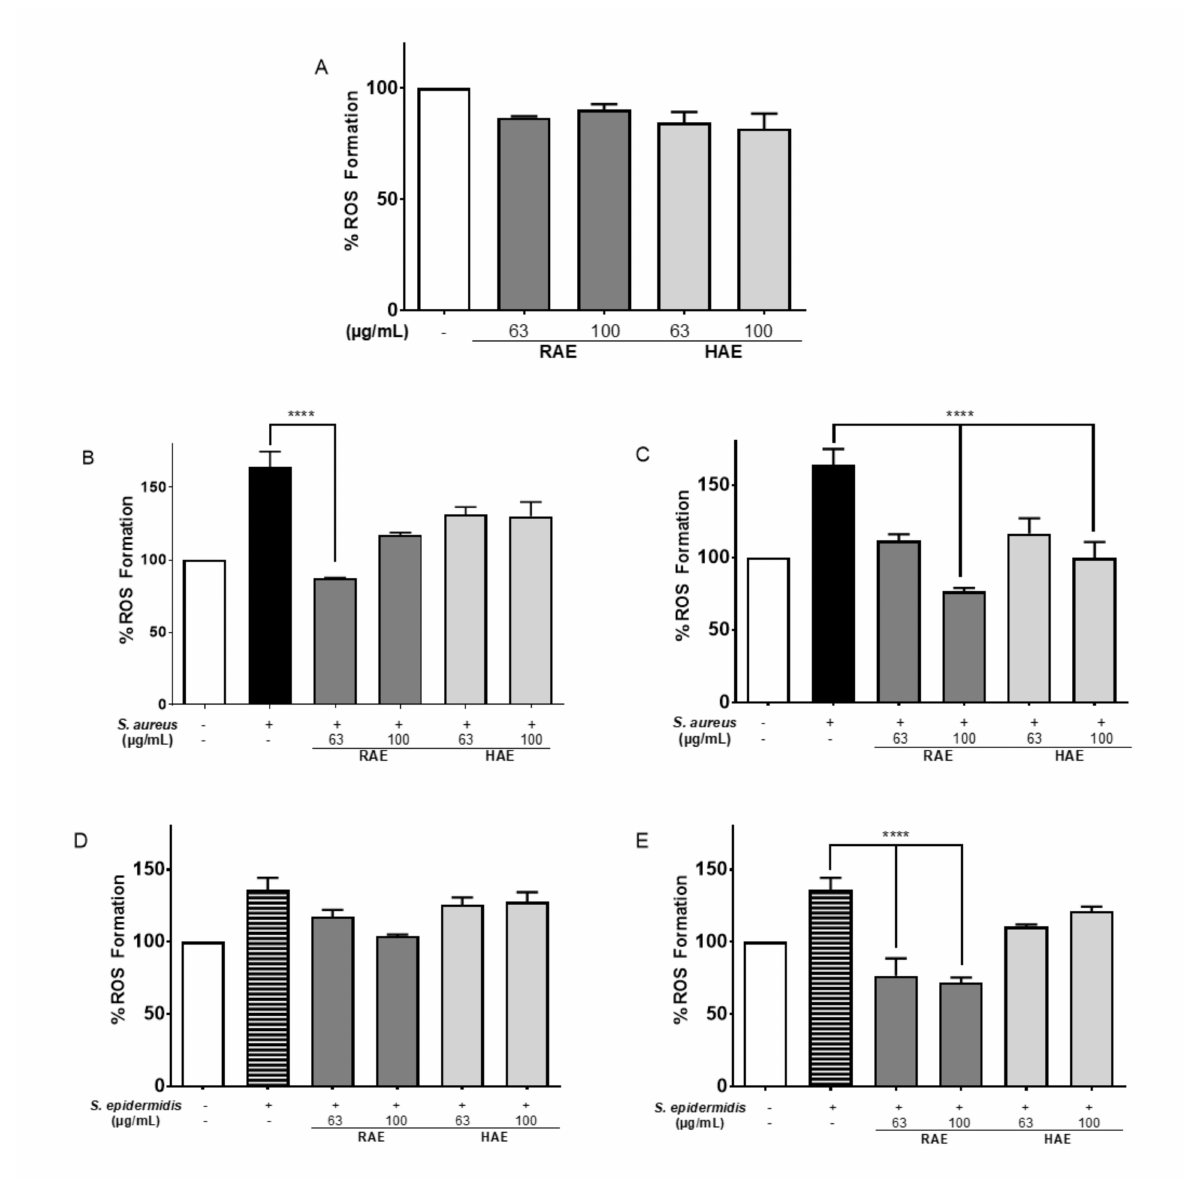
Figure 5. Percentage of reactive oxygen species. ( A ) HDFa cells exposed to MS extracts for 3 h. ( B ) Simultaneous exposure for 3 h to S. aureus and different concentrations of MS extracts. ( C ) Pretreatment for 3 h with different concentrations of MS extracts, and subsequent incubation for 3 h with S. aureus. ( D ) HDFa cells exposed for 3 h to S. epidermidis and different concentrations of MS extracts. ( E ) HDF cells pretreated for 3 h with different concentrations of MS extracts and subsequently incubated for 3 h with S. epidermidis. **** indicates p ≤ 0.0001 between the respective control of untreated cells and the treated